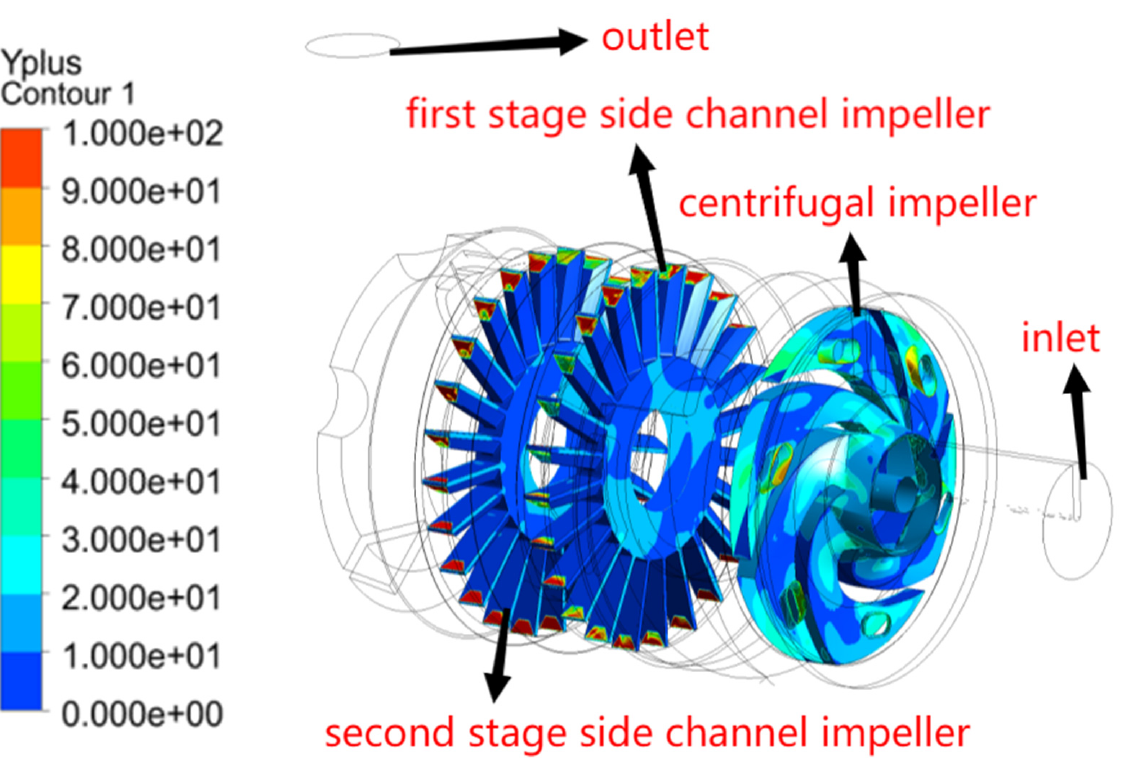
Figure 3. Grid independence verification diagram.